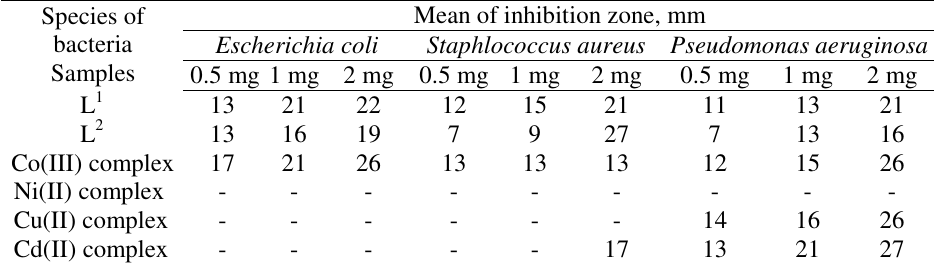
Table 3. The effect of ligands and the complexes on bacteria growth Mean of inhibition zone,